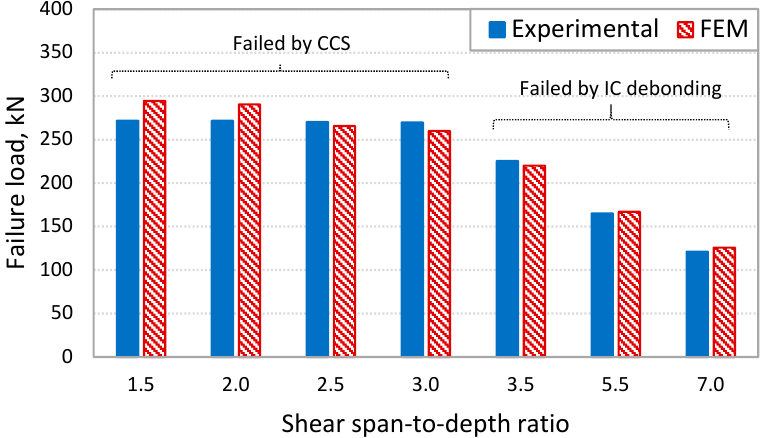
Figure 15. Comparison of FE analysis with experimental results [6] on the effect of a v / d s on debonding failures.